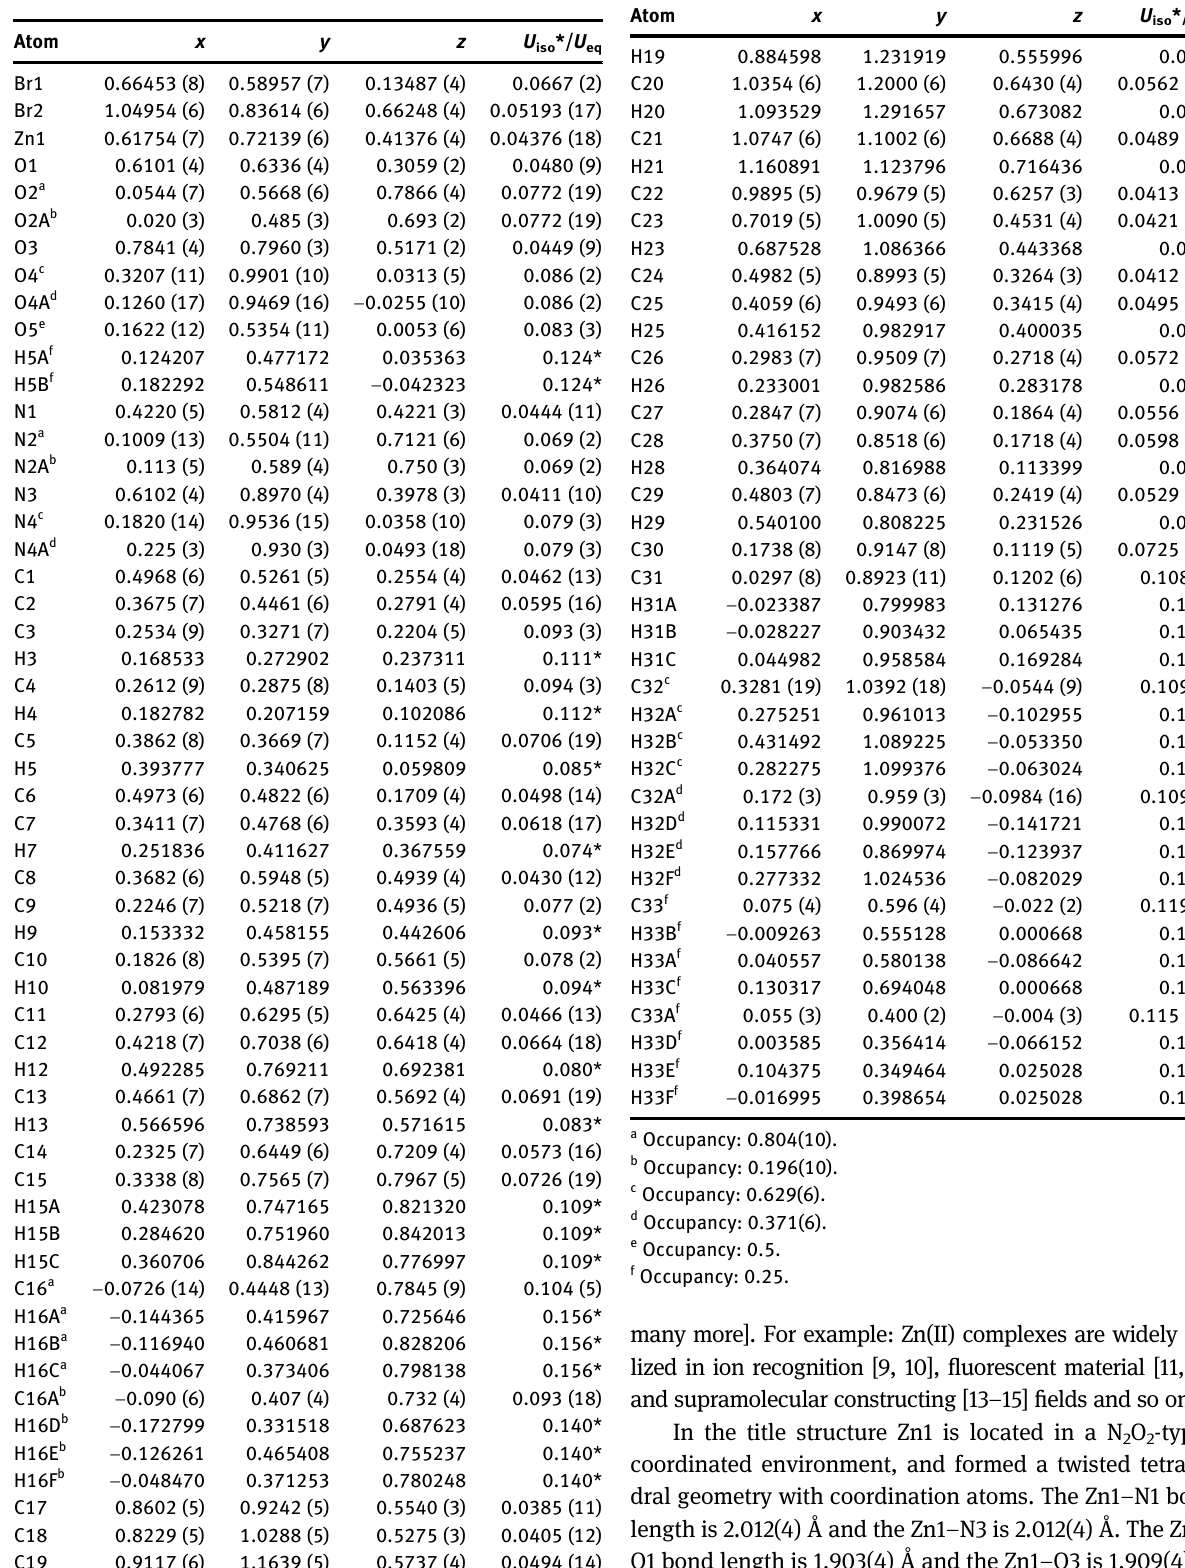
Table  : Fractional atomic coordinates and isotropic or equivalent isotropic displacement parameters (Å 